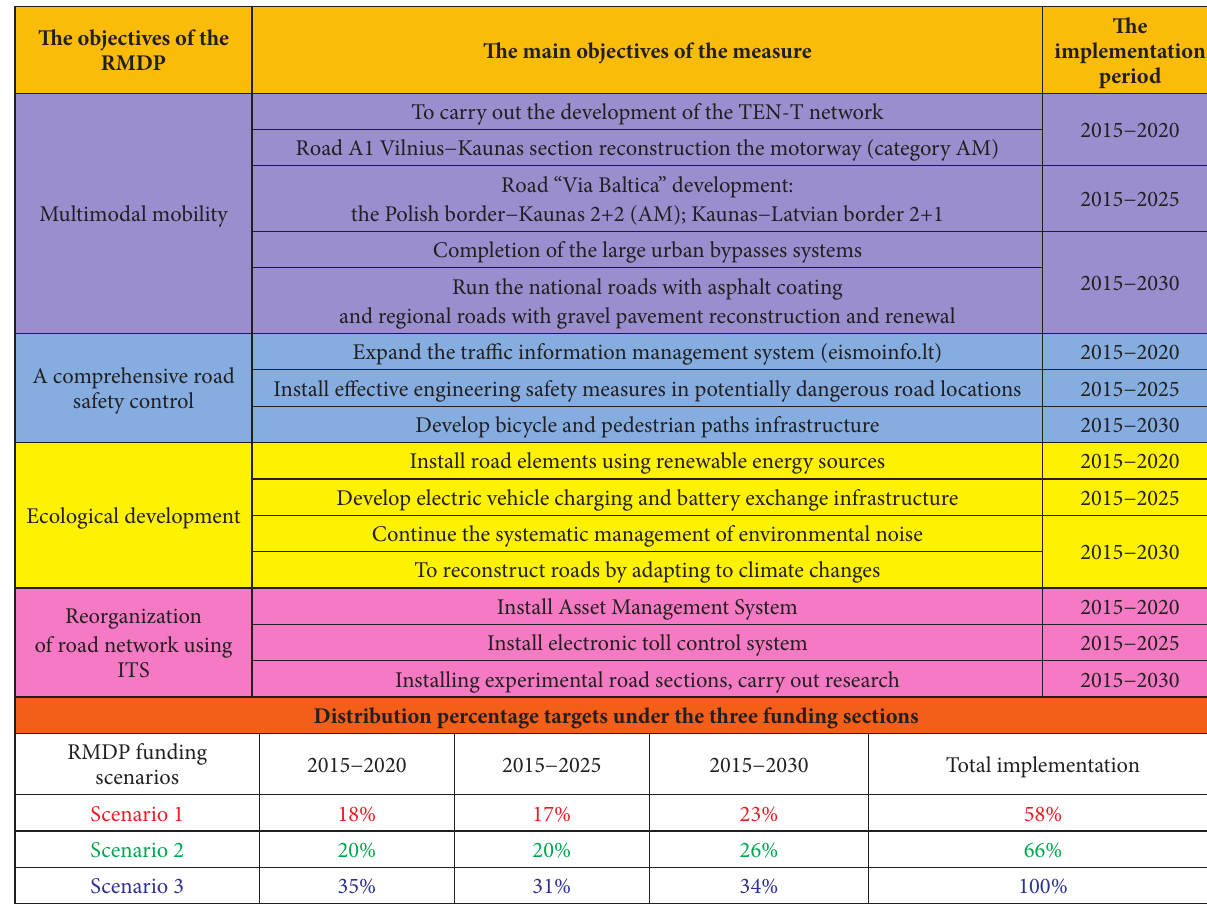
Fig. 7. RMDP priority investments and implementation by funding scenarios